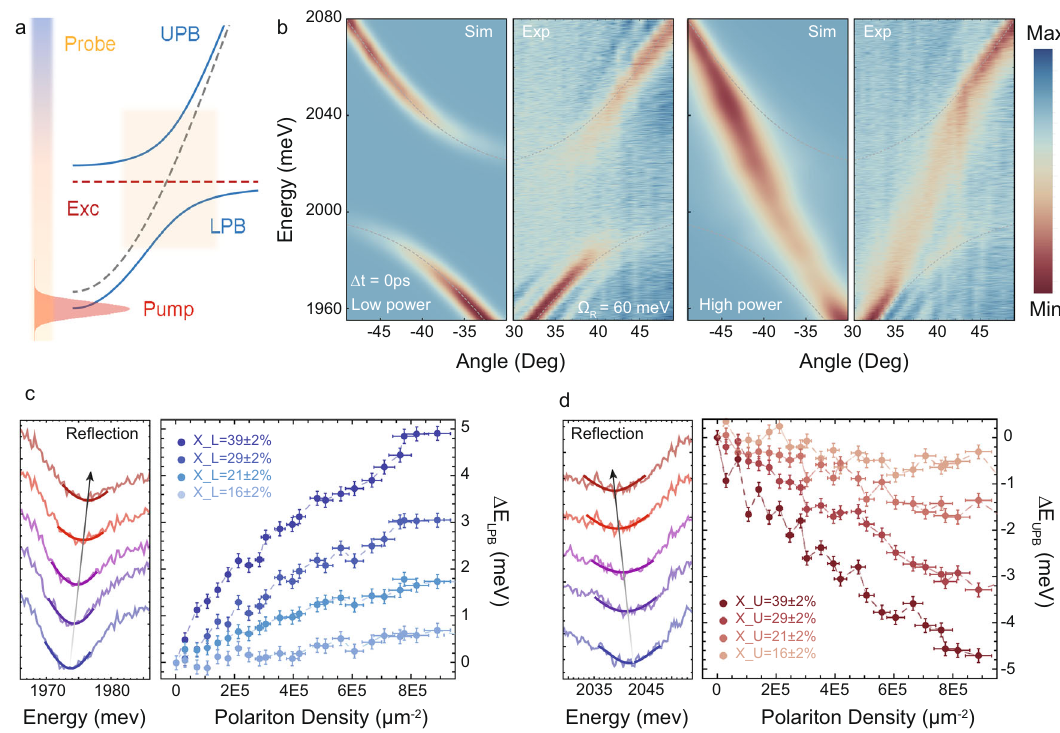
extracted at the same excitonic fraction arbitrarily shifted along the vertical axis. Energy renormalization of the LPB ( c ) and UPB ( d ) as a function of the pumping fl uencefordifferentexcitonicfractions.Theerrorbarsofpolaritondensityin c and d are explained in the “ Methods ” section. The error bars on the energy shift data correspond to the 95% con fi dence interval of the gaussian fi